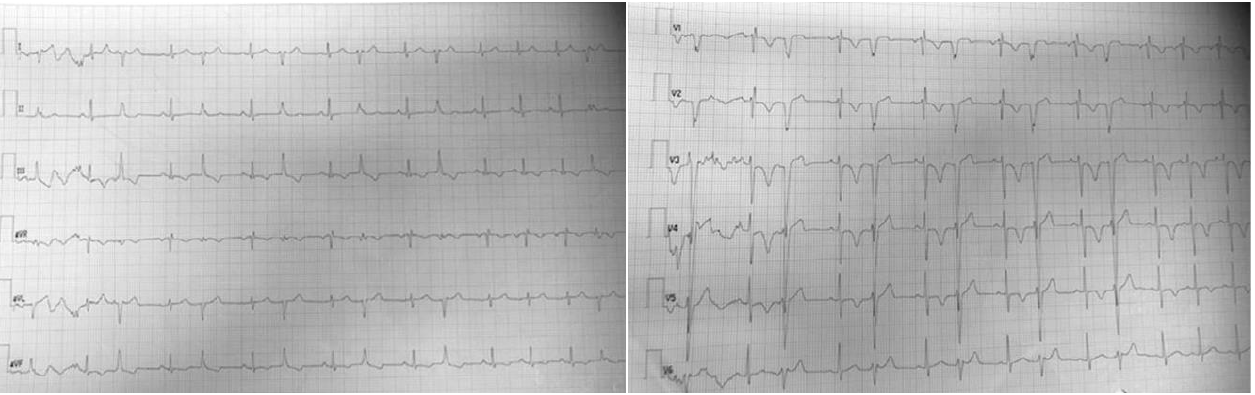
Figure 2. Color Doppler transthoracic echocardiography. Transthoracic echocardiography shows the presence of a mobile intracardiac mass protruding into the right outflow, attached to the infundibular septum by a peduncle.